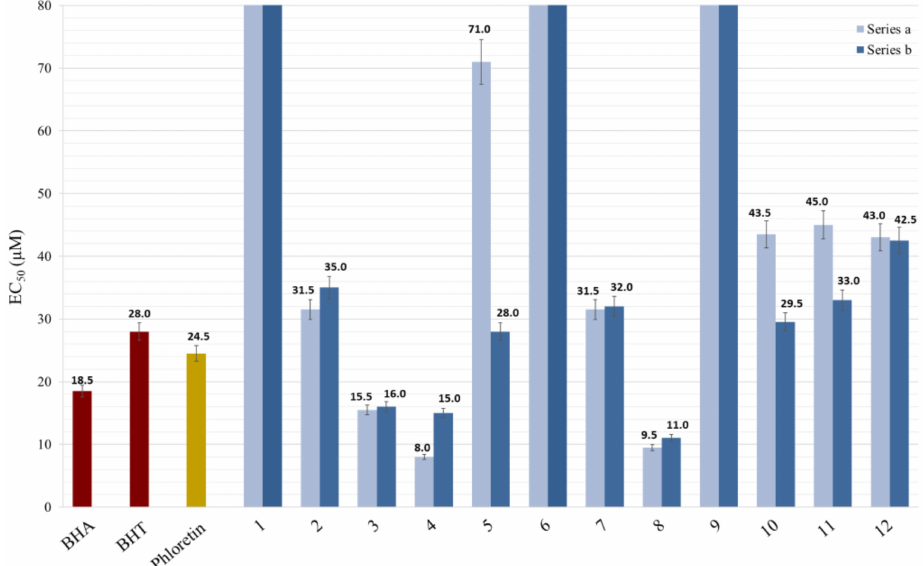
Figure 2. EC 50 values (in µ M) of synthetized molecules for DPPH inhibition in ethanol. As expected, phloretin exhibited a great antioxidant activity (EC 50 = 24.5 µ M), lower than BHA (EC 50 = 18.5 µ M), but competitive regarding BHT (EC 50 = 28 µ